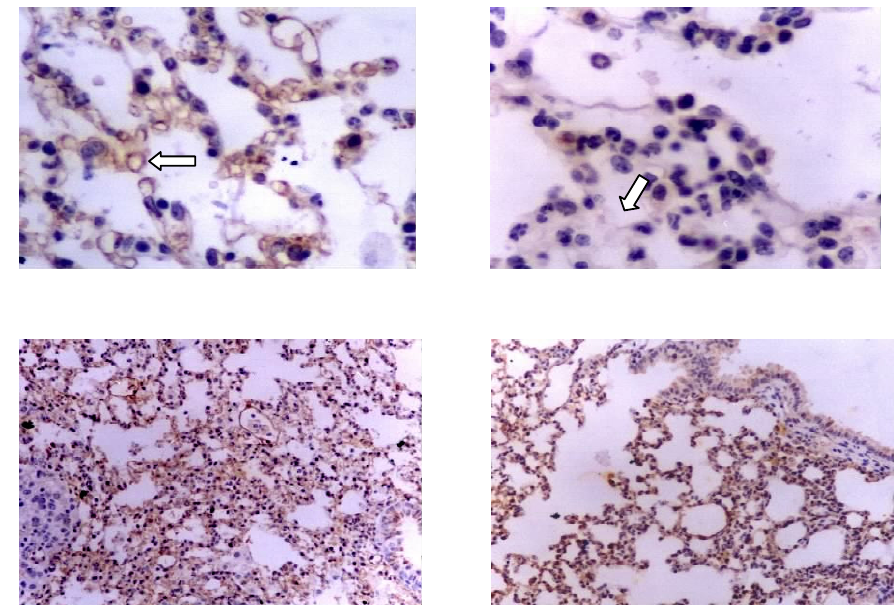
Figure 3. Localization and expression of AQP1 protein in the lungs after treatment with or without NaHCO . The arrow indicate the expression of AQP1 in alveolar epithelial cells. A: M group, showed 3 strongly positive for AQP1 in mice bearing Lewis lung carcinoma ( · 400); B: treated